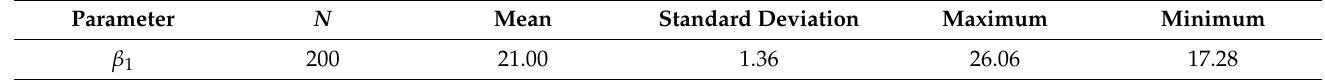
Figure 6. Estimation of σ c from the correlations with I s , I s (50) , and I s (50) of Table 1 for limestone.